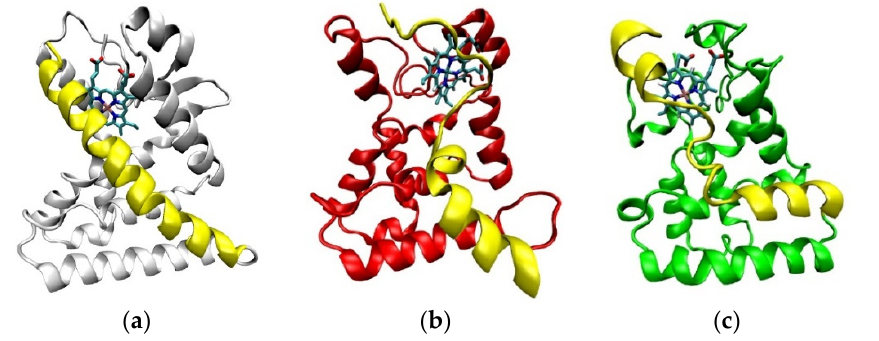
Figure 11. The visualization of Helix-11 (yellow) in Agonist-REV-ERB β on the crystal structure ( a ), after molecular dynamic simulation in complex with CoPP ( b ) and in complex with Heme ( c ).